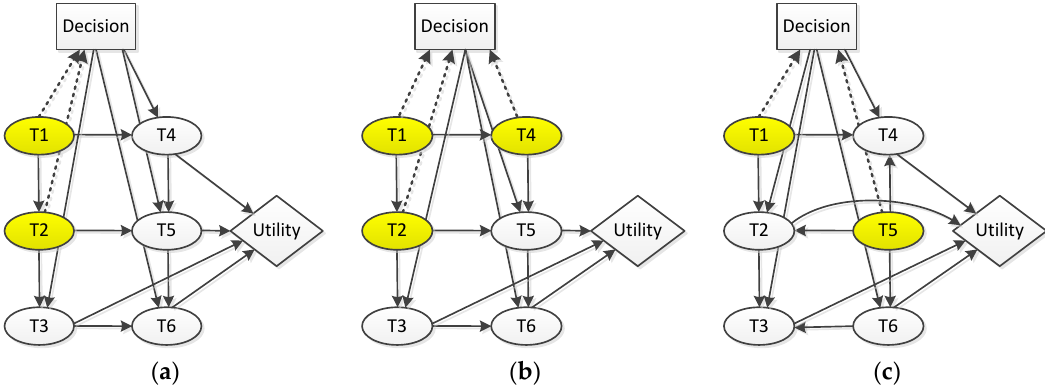
Figure 9. Influence diagrams to identify the optimal firefighting strategies in ( a ) Scenario 1, ( b ) Scenario 2, and ( c ) Scenario 3.